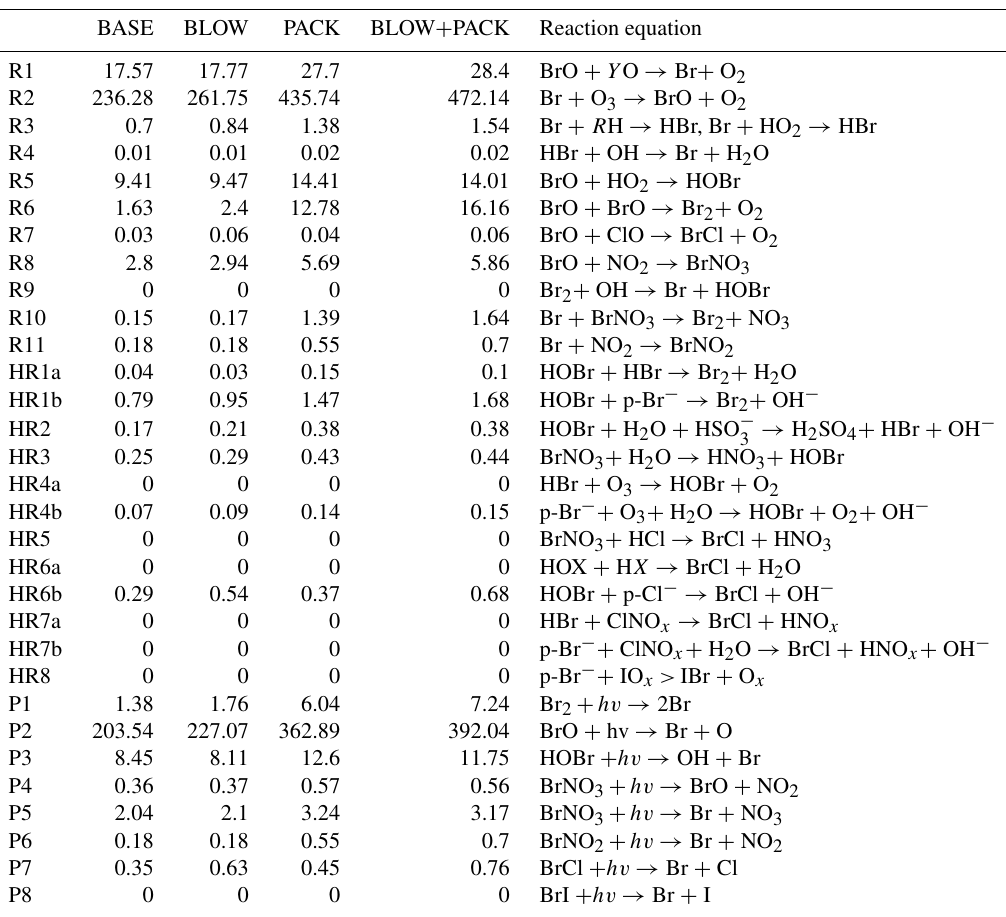
Table 3. Arctic tropospheric reaction rates by model run. Rates for each of the simulated reactions listed in Fig. 1 grouped by GEOS-Chem run. All units are listed as millions of moles per hour across the region shown in Supplement Fig. S14. R in Reaction (R3) refers to any organic molecule. Y in Eq. (1) represents NO, Cl, or H. X in Eq. (HR6a) represents either Br or Cl. PHOTOPACK and BLOW + PHOTOPACK are excluded as they severely overpredict BrO, as seen in Figs. 4 and 5.